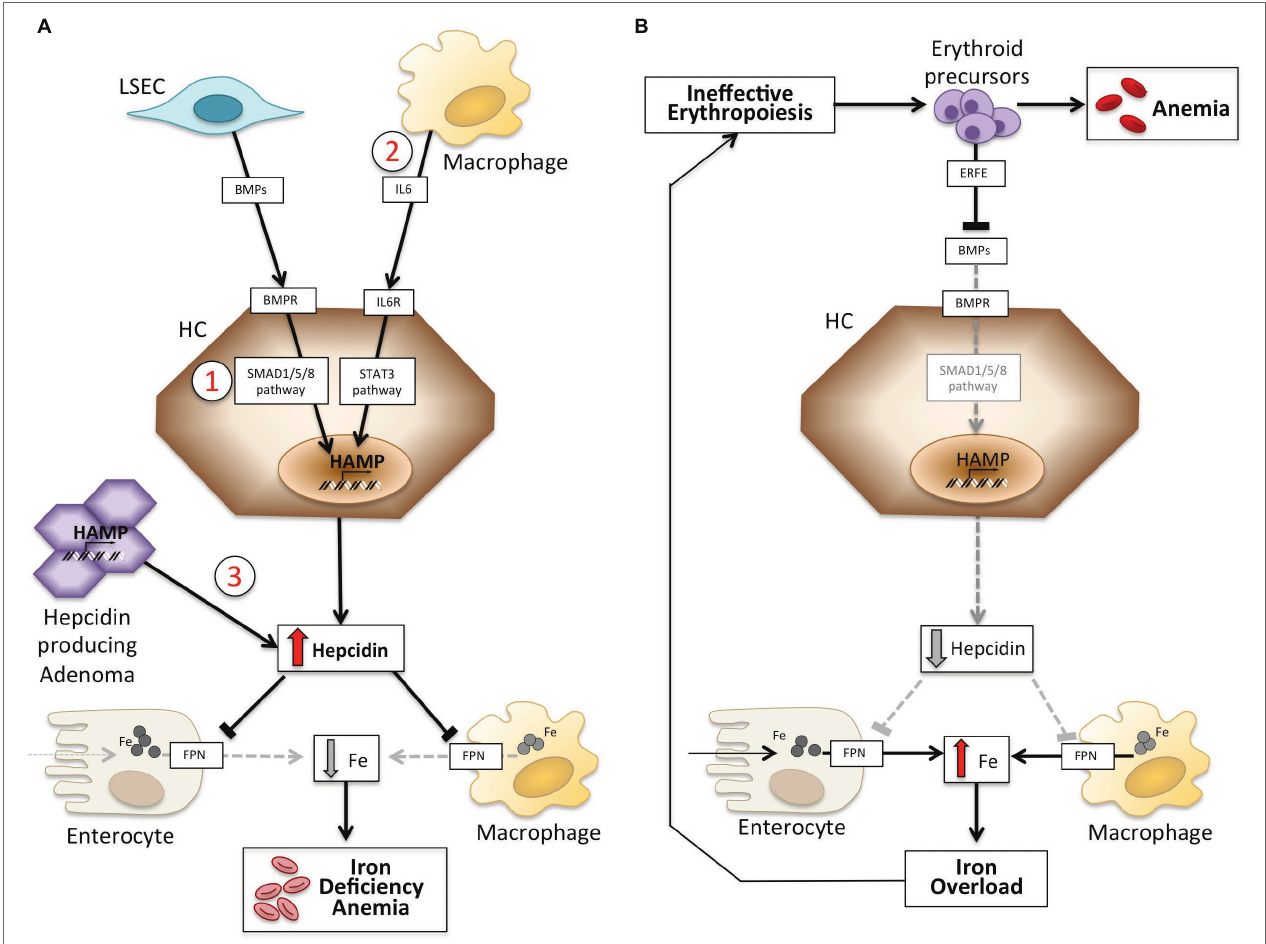
FIGURE 1 | Schematic representation of mechanisms of anemias with high (left panel) and low hepcidin (right panel). Panel (A) . Molecular pathogenesis of anemia associated with high hepcidin levels. LSEC, liver sinusoidal endothelial cells producing bone morphogenetic proteins (BMPs); BMPRs, BMP receptors; IL6, interleukin 6; HC, hepatocytes; HAMP, hepcidin gene. Fe, iron; FPN, ferroportin; 1, IRIDA; 2, Anemia of inflammation; 3, hepcidin producing adenoma. Panel (B) . Molecular pathogenesis of hepcidin variation in anemias due to ineffective erythropoiesis. ERFE, erythroferrone sequestering BMPs. Other mechanisms inhibiting hepcidin in this type of anemia, as decrease of transferrin saturation and hypoxia, are not shown. See text for